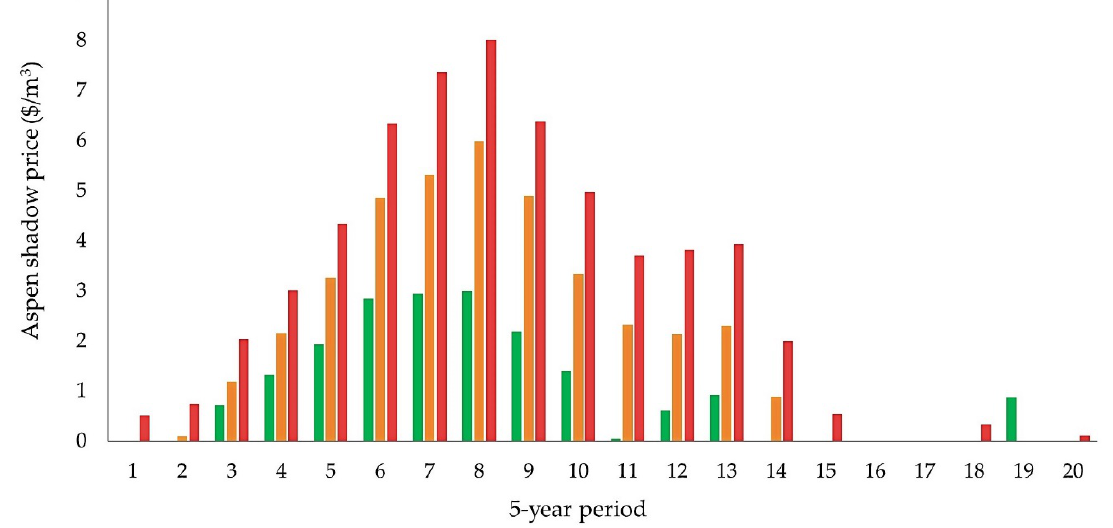
Figure 10. Marginal values for the aspen species volume constraints across marginal value functions.